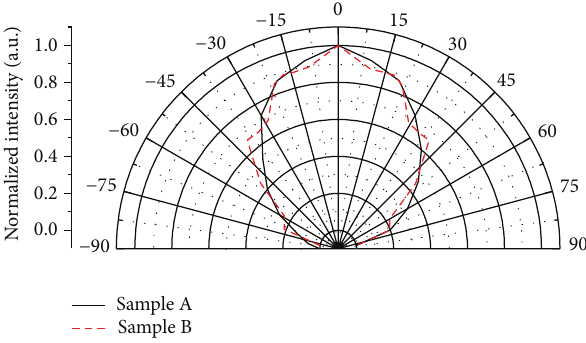
Figure 4: Measured far-field pattern for the OLEDs devices of Sample A and Sample B.